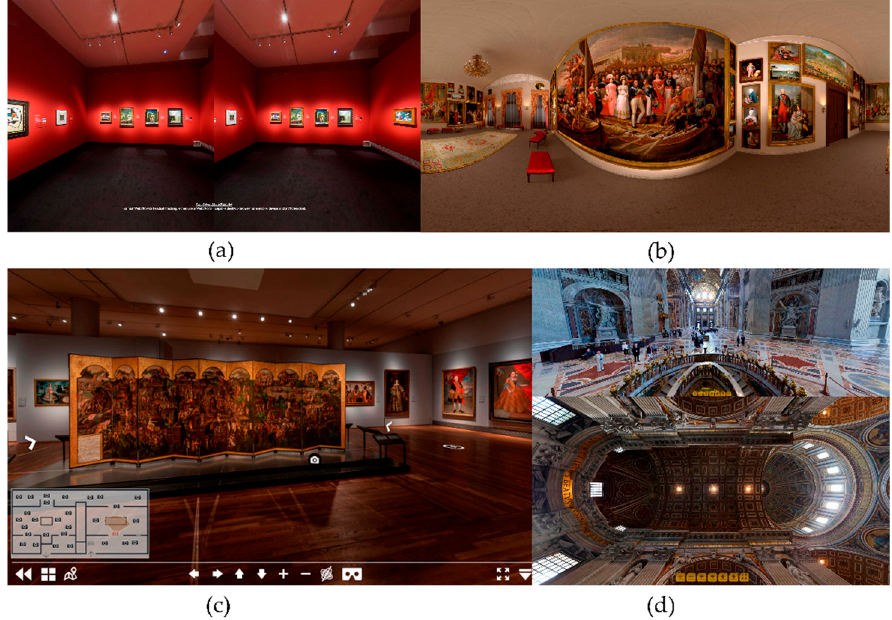
Figure 3. ( a ) On the left is WebVR with headset tracking of the collection “Dalí and surrealism” from the International Museum Thyssen-Bornemisza; ( b , c ) virtual visit: “Mythological Passions” of the Prado Museum; ( d ) virtual tour of Saint Peter’s Basilica in the Vatican. Details of the Sistine Chapel.